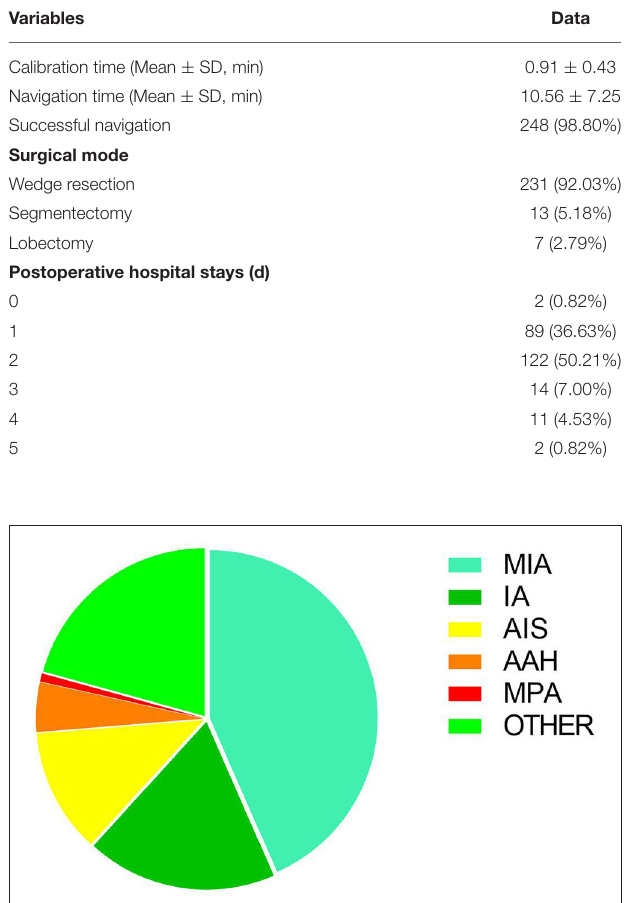
TABLE 1 | Baseline characteristic ( n = 243).